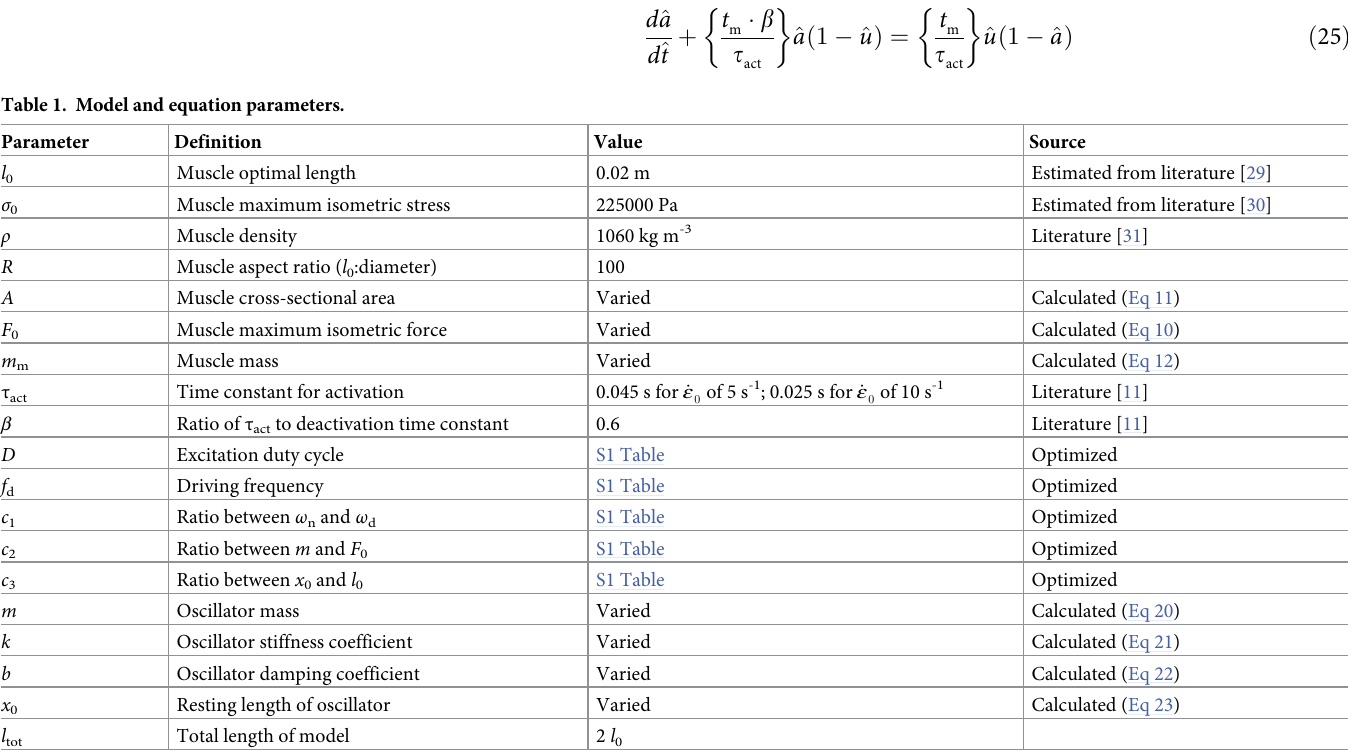
Table 1. Model and equation